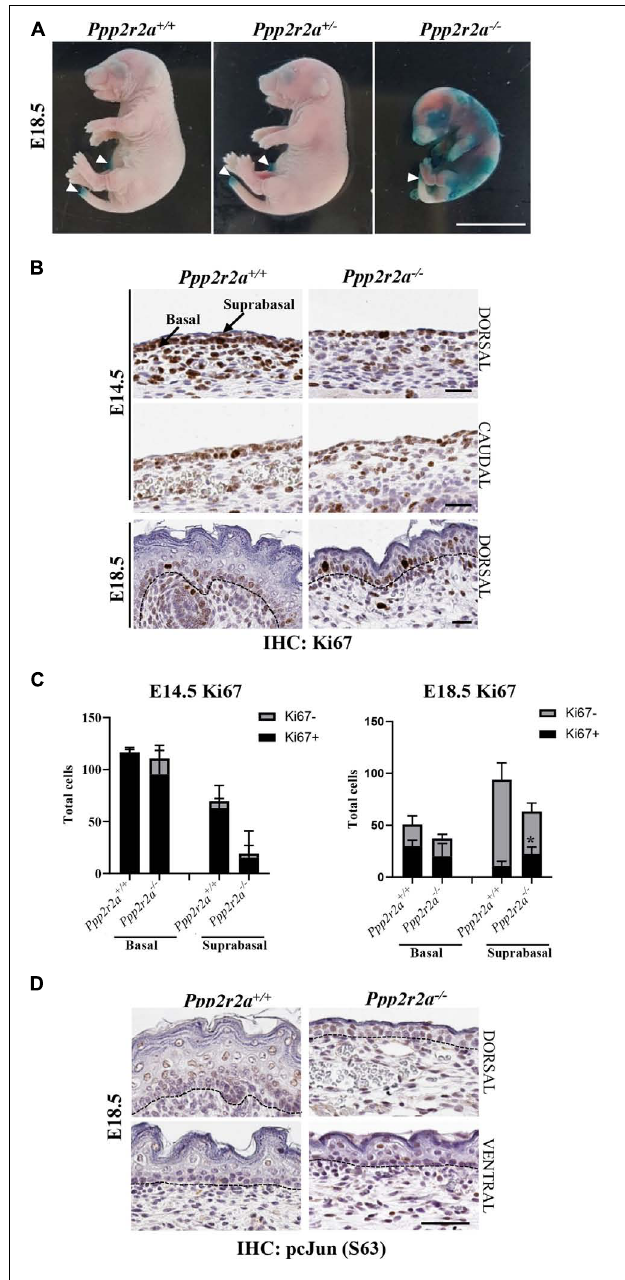
FIGURE 8 | Defective epidermal barrier in Ppp2r2a knockout embryos is associated with changes in proliferation, and p-cJun signaling. (A) X-gal substrate penetration (permeability) assay in E18.5 embryos. Areas stained blue on the Ppp2r2a − / − embryo indicates regions with an impaired epidermal barrier. White arrowheads mark regions (umbilical cord and tail) that stained blue as they were cut during dissection. Representative of n = 3. Scale bar = 1 cm. (B) Ppp2r2a + / + and Ppp2r2a − / − epidermal regions at E14.5 and E18.5 showing Ki67 (proliferation marker) staining. Dashed black line indicates the dermal-epidermal junction. (C) Quantitation of Ki67 positive and negative cells in E14.5 and E18.5 epidermis. Ki67 + cells were significantly increased in the Ppp2r2a − / − suprabasal epidermis compared to the wild-type. * p < 0.05, unpaired two-tailed t -test. (D) IHC for p-cJun (S63) in Ppp2r2a + / + and Ppp2r2a − / − epidermal regions. Dashed black line indicates the dermal-epidermal junction. All scale bars = 50 µ